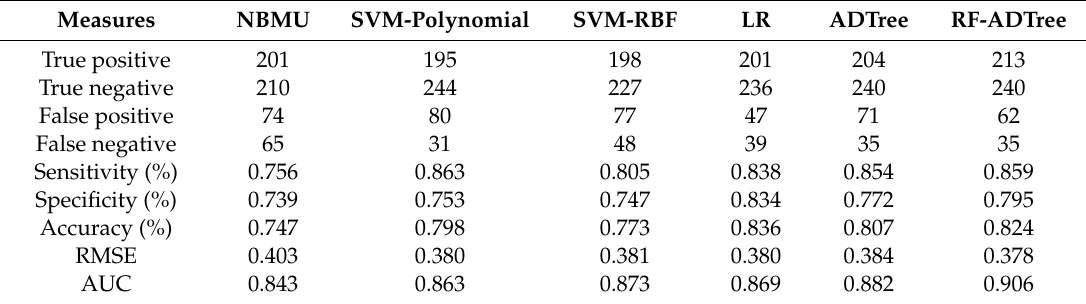
Table 4. Model performances in the validation dataset for the new hybrid “RF-ADTree” model and other benchmark models.